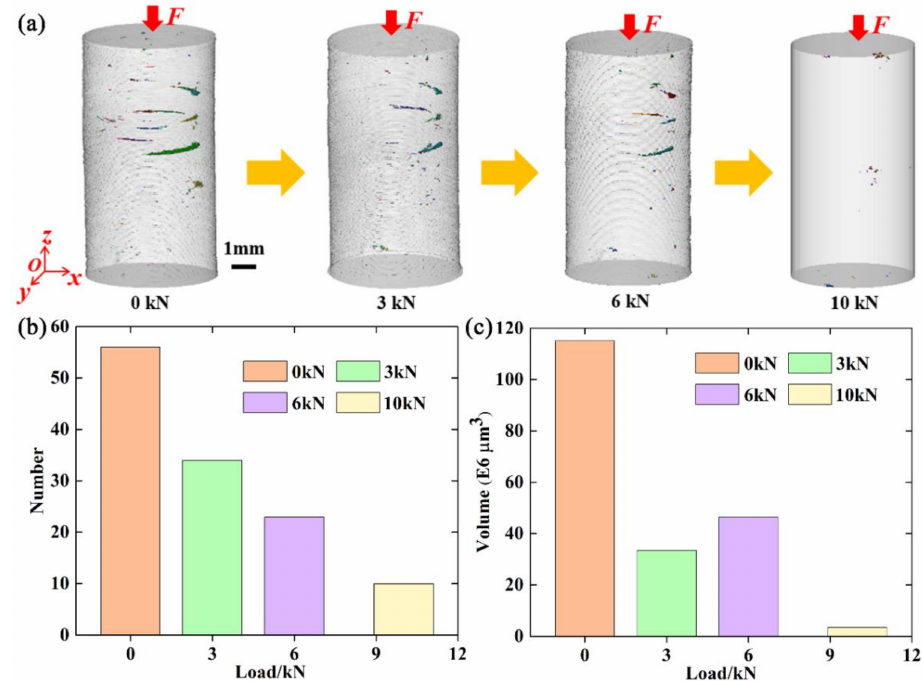
Figure 8. ( a – c ): Three-dimensional volume rendering, number, and volume, respectively, of the transverse cracks at different compressive loads.